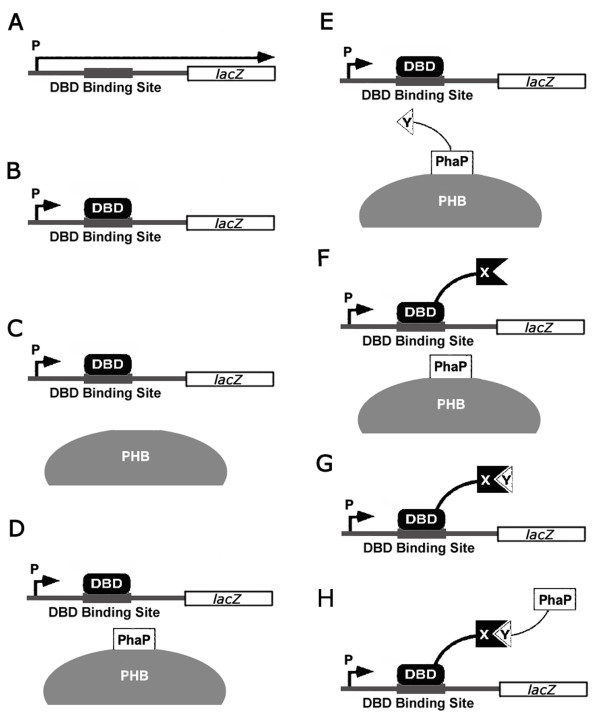
Experiment diagram of interaction between essential elements in this two-hybrid system. In order to examine whether interactions happen among several essential elements involved in this two-hybrid system, such as phaP promoter, DBD, PhaP, lacZ reporter gene, interaction protein partners and PHB granules. E. coli XL1-Blue harboring plasmids were cultured to detect the possible interaction between these elements by detecting β-galactosidase activity. DBD regulates LacZ expression by turning DBD on/off the DBD binding site of phaP promoter. (A) pOZ, the promoter of phaP can give rise to strong expression of LacZ; (B) pDBD-Z, DBD can suppress LacZ expression by binding on DBD binding site of phaP promoter; (C) pDBD-Z and pBHR68, PHB granules can not pull down DBD from DBD binding site, indicating DBD has no interaction with PHB granules; (D) pDBD-Z and pP-CAB, similar with (C), PhaP can not pull down DBD, indicating DBD has no interaction with PhaP; (E) pDBD-Z and pFos-P-CAB, similarly, DBD has no interaction with PhaP-bFos fusion; (F) pDBD-Jun-Z and pP-CAB, similarly, DBD-bJun has no interacton with PhaP; (G) pDBD-Jun-Z and pFos, when PHB granules are absent, the interaction of DBD-bJun and bFos can not give rise to LacZ expression; (H) pDBD-Jun-Z and pFos-P, when PHB granules are absent, the interaction of DBD-bJun and PhaP-bFos can not give rise to LacZ expression; These assays were used to eliminate the influences of unspecific interaction, which was so called background noise. X: bait protein; Y: prey protein.